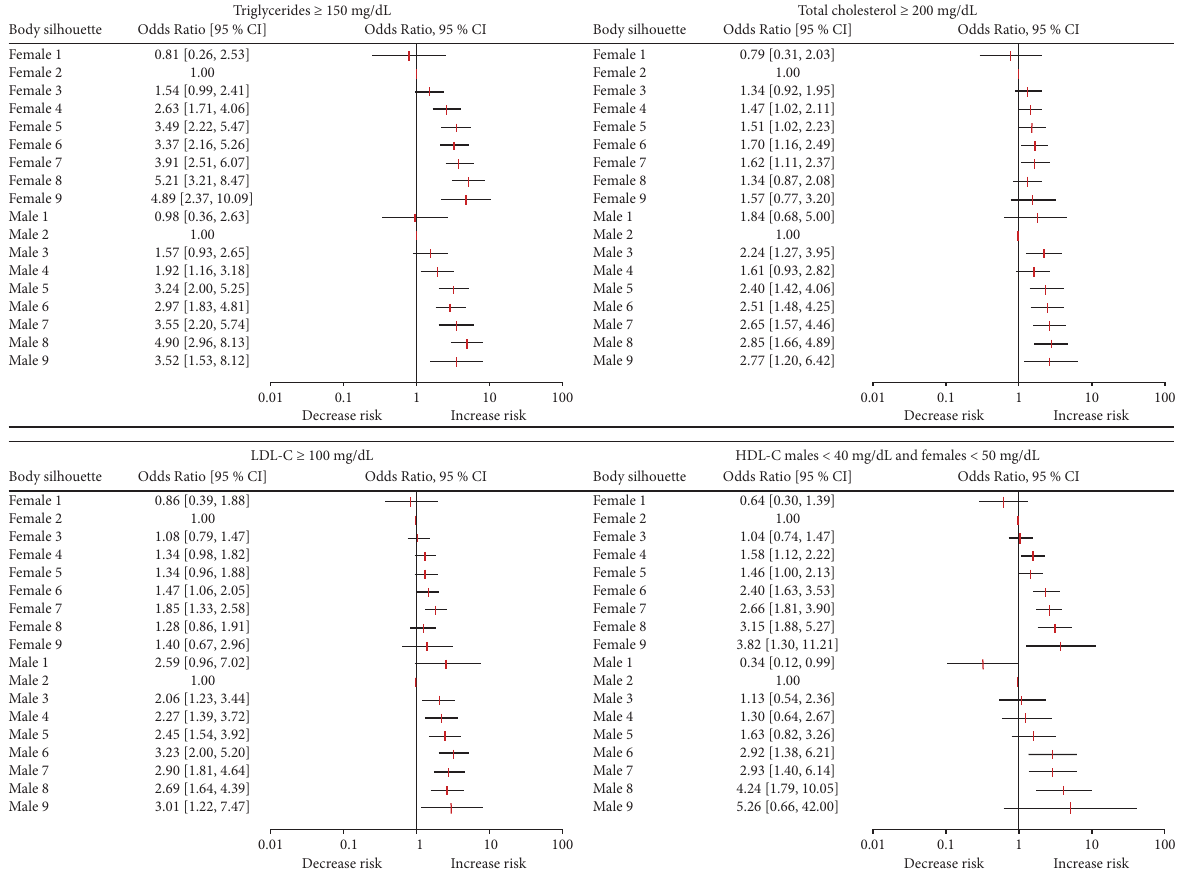
Figure 3: Risk assessment of triglycerides ≥ 150mg/dL, total cholesterol ≥ 200mg/dL, LDL-C ≥ 100mg/dL, and low HDL-C (males < 40 mg/ dL, females < 50mg/dL), for each self-reported body silhouette for both females and males. All models were adjusted by